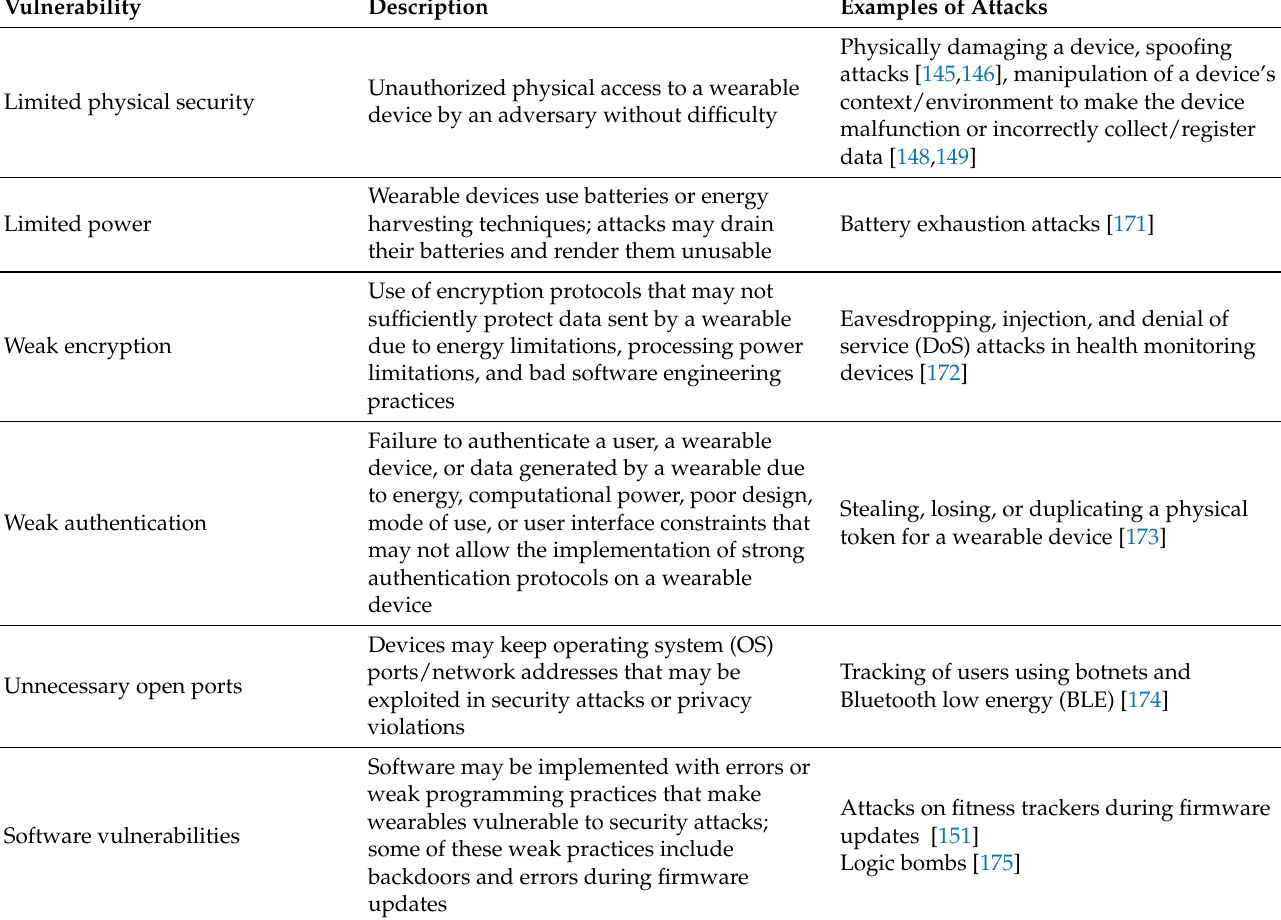
Table 5. Vulnerabilities in wearable sensing devices (adapted from